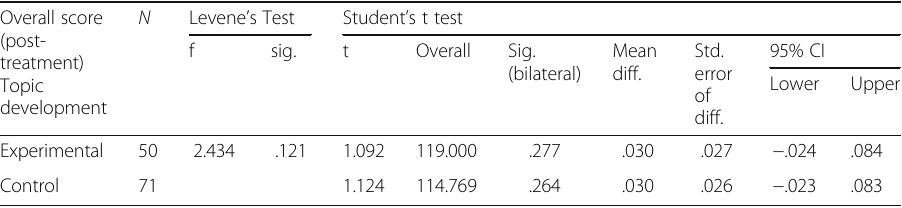
Table 8 Comparative analysis of mean level of progress in topic development post-treatment Overall score